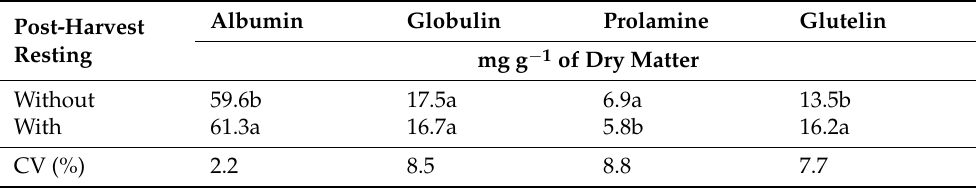
Table 3. Albumin, globulin, prolamine and glutelin content in sweet pepper seeds as a function of post-harvest resting of the